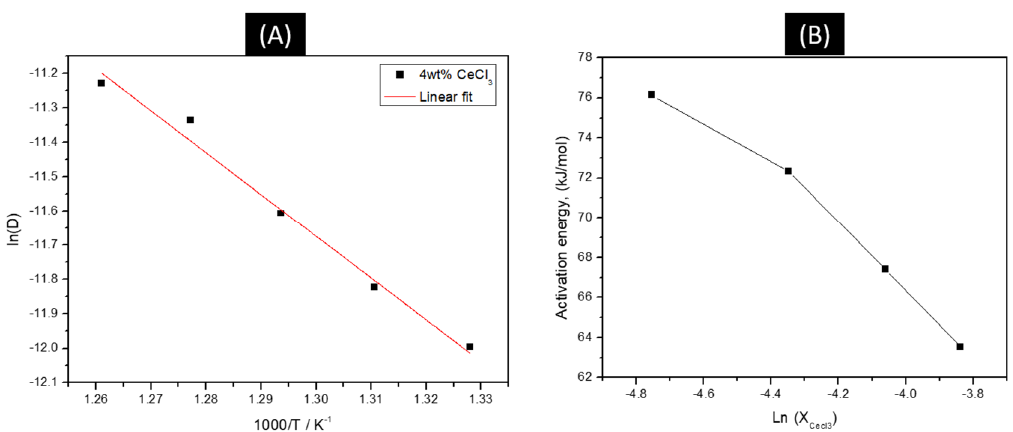
Figure 4. ( A ) Linear relationship of the logarithm of CeCl 3 diffusion coefficient vs. the reciprocal of the absolute temperature. ( B ) Activation energy as a function of CeCl 3 concentration.